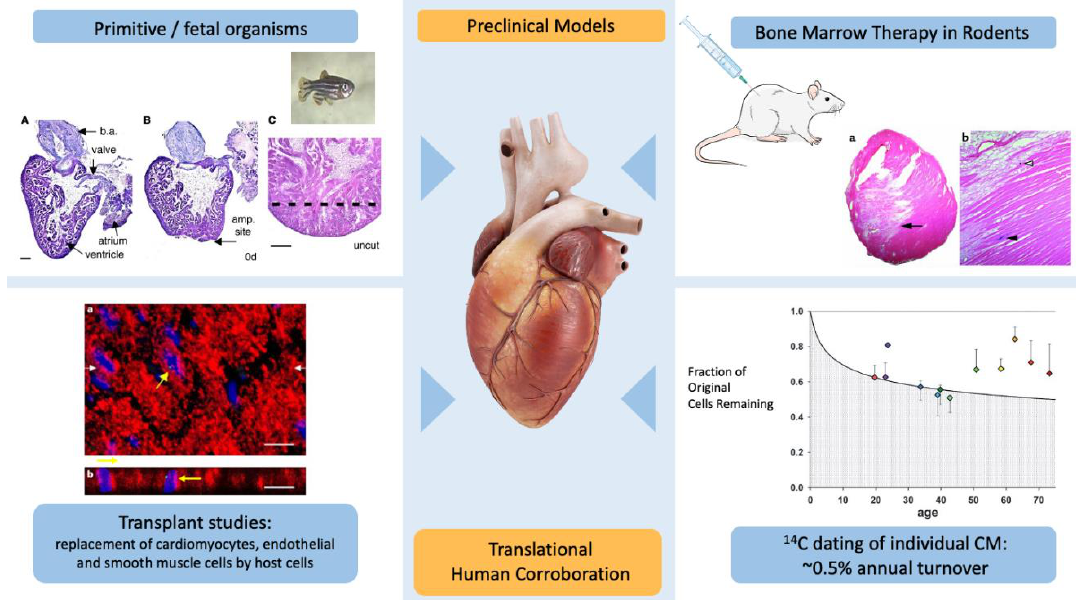
Figure 1. Evidence Supporting Possibility of Stem Cell Medicated Cardiac Repair. Top left: Primitive organisms such as zebrafish are able to regenerate significant (~25%) of resected myocardium with histologically identical myocardium. Adapted with permission [2]. Top right: early reports of use of bone marrow cells suggested significant trans-differentiation and generation of new myocardium, reports which were frequently difficult to reproduce. Adapted with permission [4]. Bottom right: Evidence of human myocardial regeneration based on 14 C myocyte content suggests turnover of ~0.5% per year which decreases with age. Adapted from with permission [13]. Bottom left: A series of studies suggested replacement of transplanted endothelial, vascular, and myocyte tissue by host cells, although the rate of myocardial replacement was in most cases low (~0.04%). Adapted from with permission [14] .